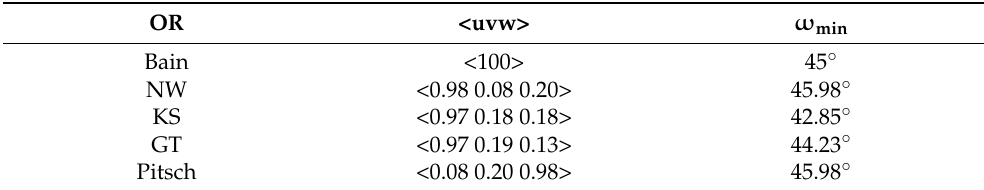
Table 3. Overview of the different ORs between fcc and bcc crystals and the respective misorientation axis/angle.